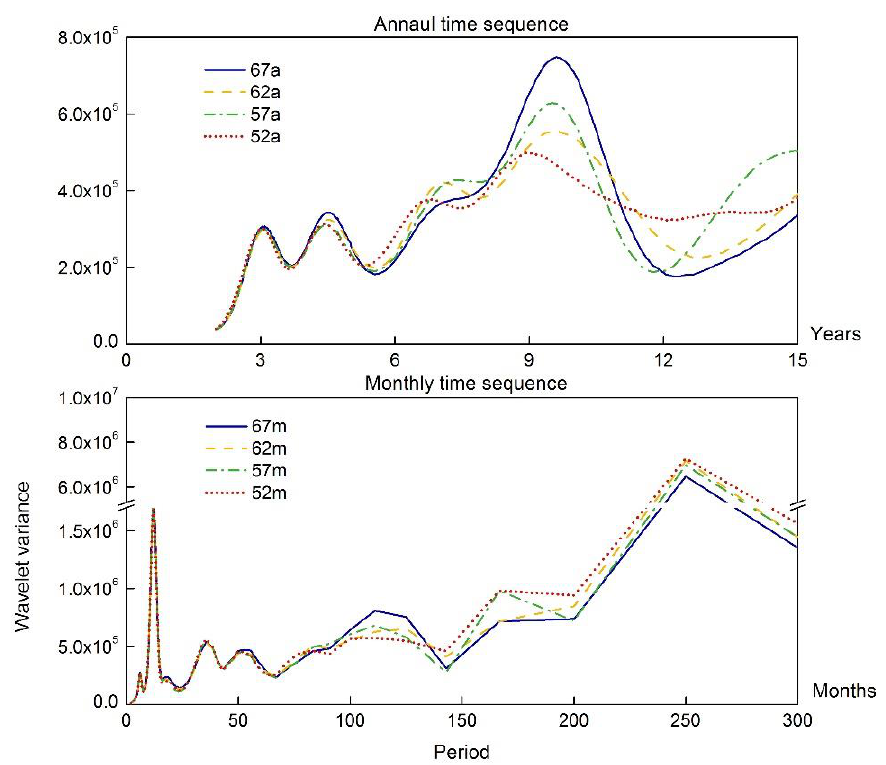
Figure 8. Wavelet spectra of HHS.